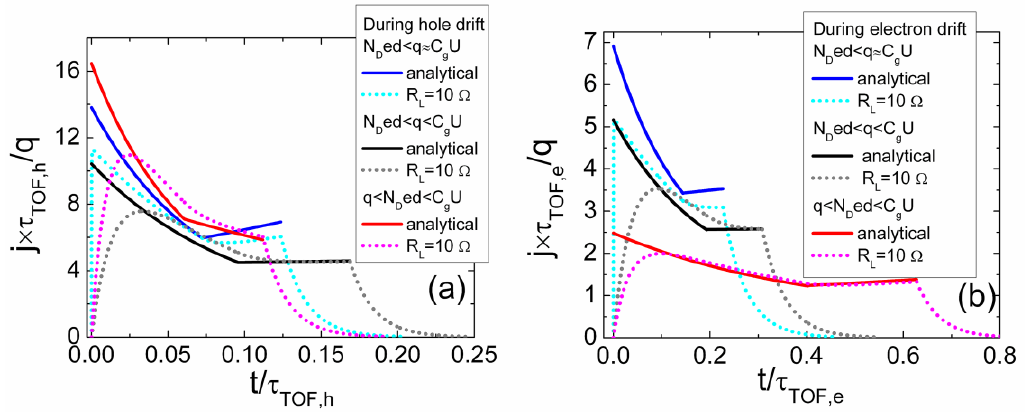
Figure 4. Transients of the normalized current density j ×  charge drift during hole ( a ) and electron ( b ) drift times for various regimes, dependent on the densities of the drifting charge and of the space charge of ions. Solid curves are calculated using the derived above analytical expressions, while the dotted curves are obtained including the RC of a signal recording